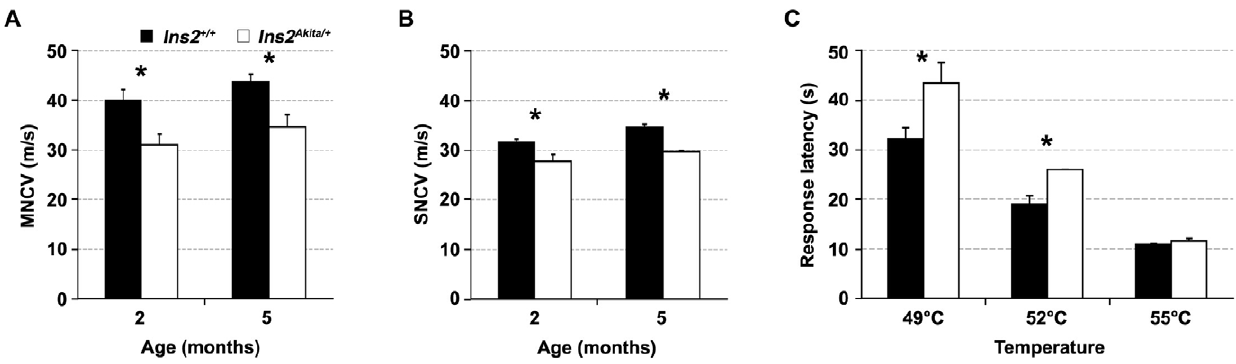
Figure 2. Characterization of motor and sensory behavior in Ins2 Akita// + mice. Sciatic nerve motor (MNCV, A) and tail sensory (SNCV, B) nerve conduction velocities were compared in diabetic ( Ins2 Akita/ + ) and control ( Ins2 + / + ) mice at two and five months of age. Results are expressed as the mean 6 standard error of the mean (S.E.M). ( Ins2 + / + : n=4; Ins2 Akita/ + : n=4). C) Sensory performances were evaluated in two month old Ins2 Akita/ + and control littermates using the hot plate test at 49, 52 and 55 u C. Results are expressed as the mean 6 standard error of the mean (S.E.M.) and analyzed by Student’s t test ( Ins2 + / + : n=8; Ins2 Akita/ + : n=7). (*) p , 0.05.